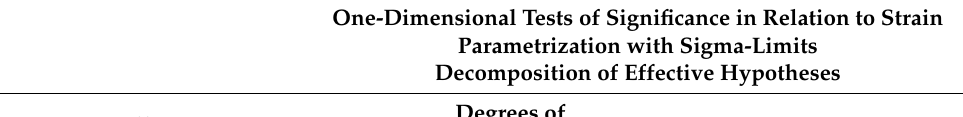
Table 3. Results of the multi-factor analysis of